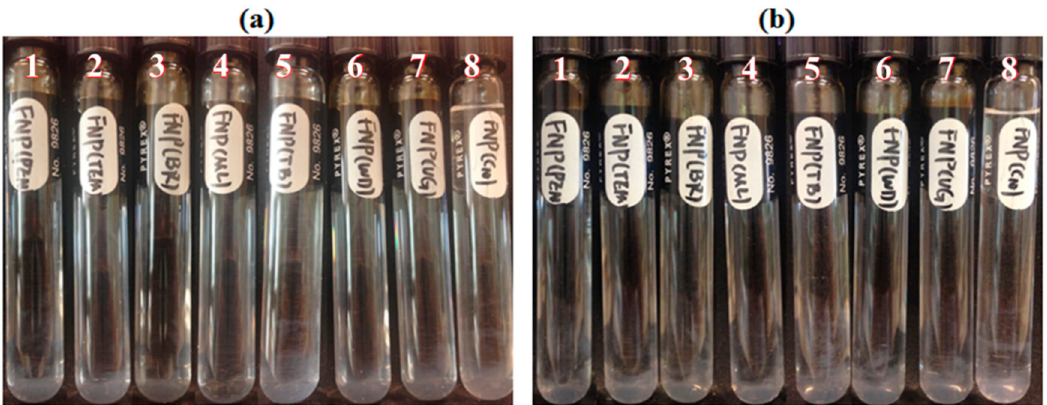
Figure 12. FNP suspensions stability screening with different type of oils: ( a ), Day 1; ( b ), Day 2; (1: CO1;